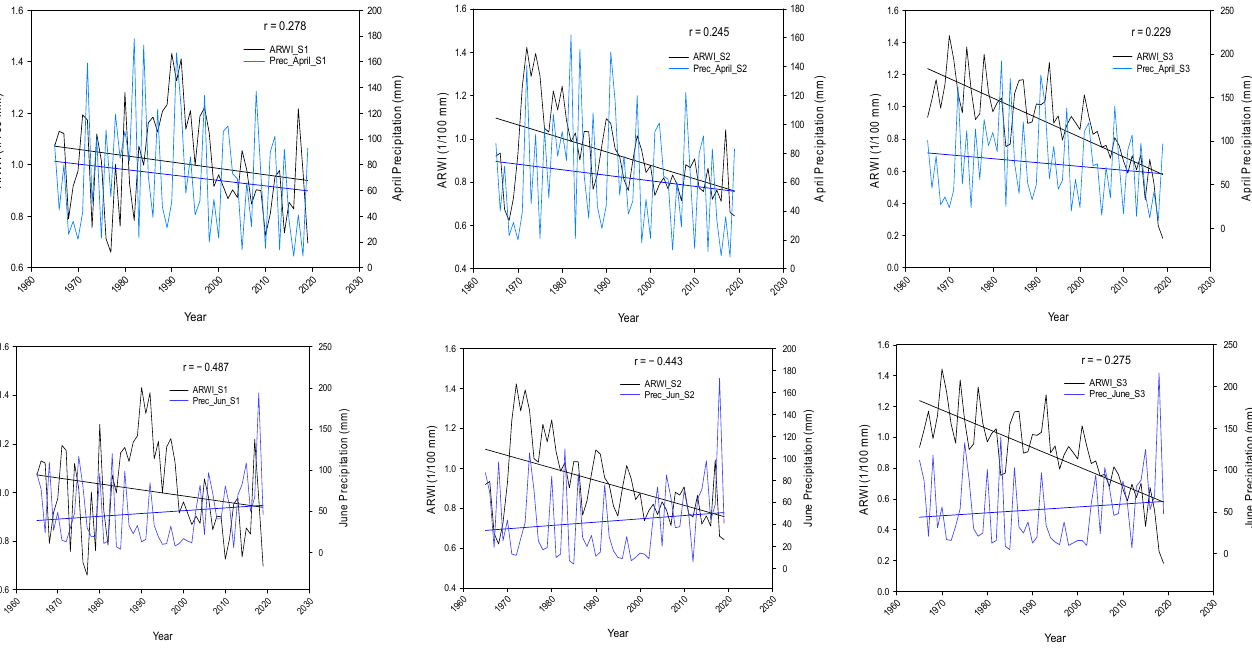
Our fi ndings demonstrate a variation in the behavior of the three stands when ex-